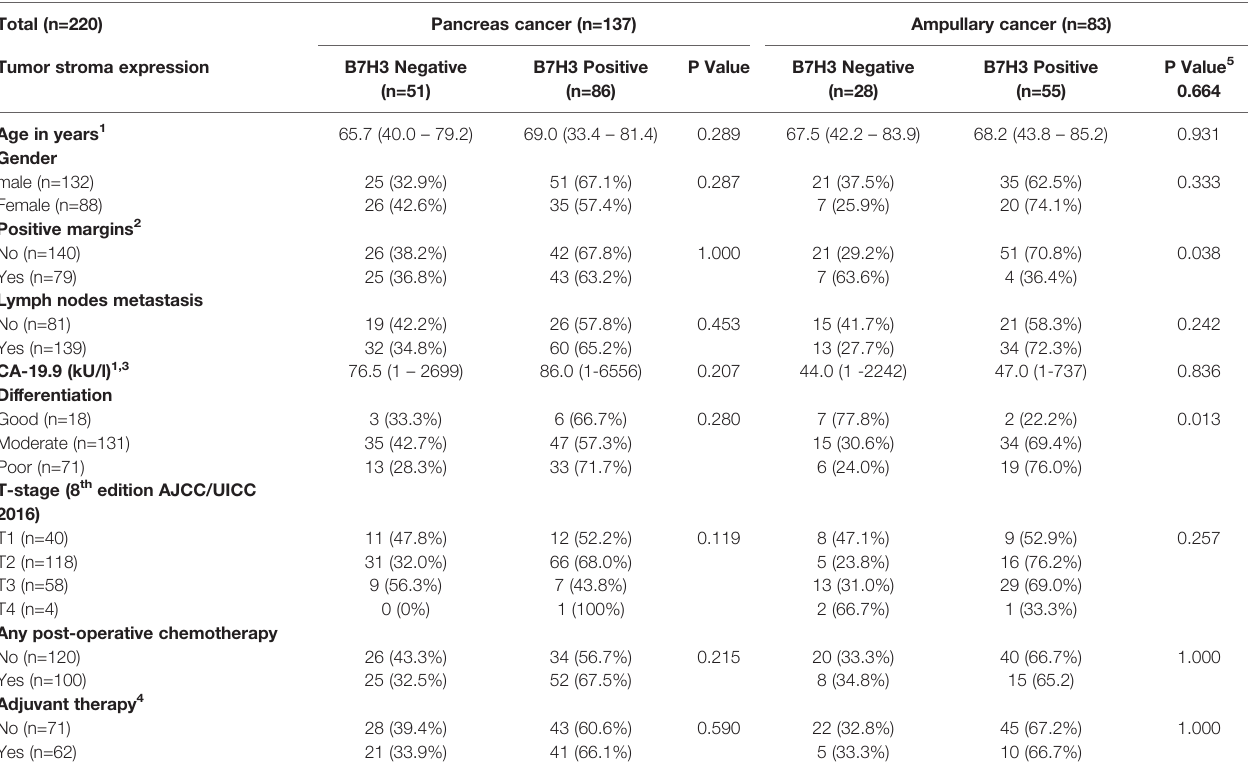
TABLE 2 | Tumor stroma expression of B7-H3 and baseline characteristics of pancreatic cancer and ampullary cancer